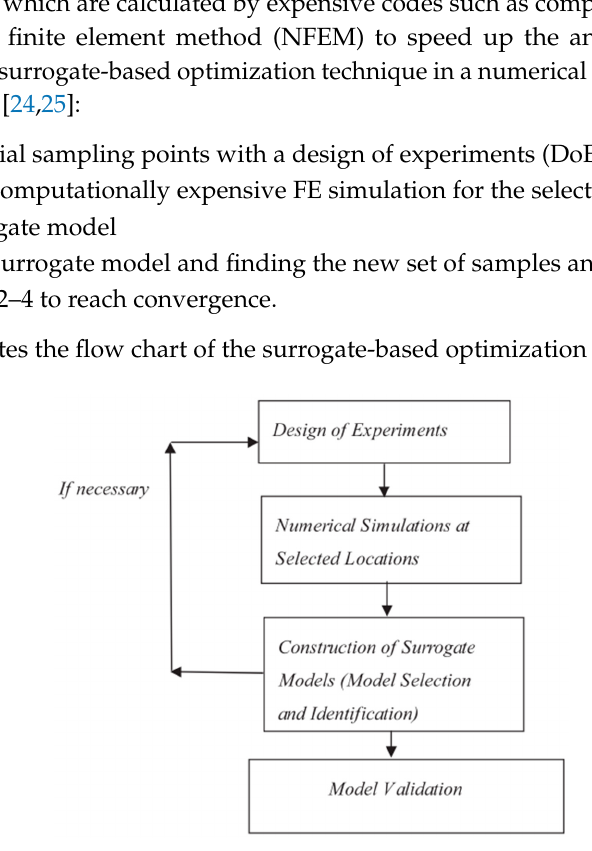
Figure 11. The flow chart of the surrogate-based optimization method.